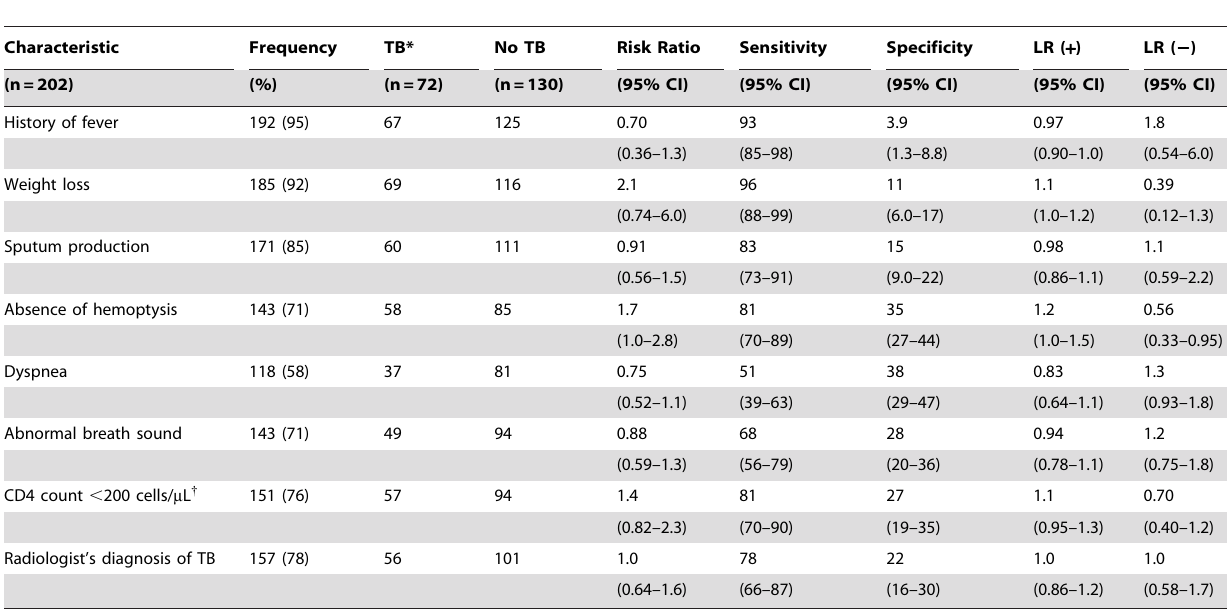
Table 2. Diagnostic performance of clinical and radiographic characteristics with high sensitivity for